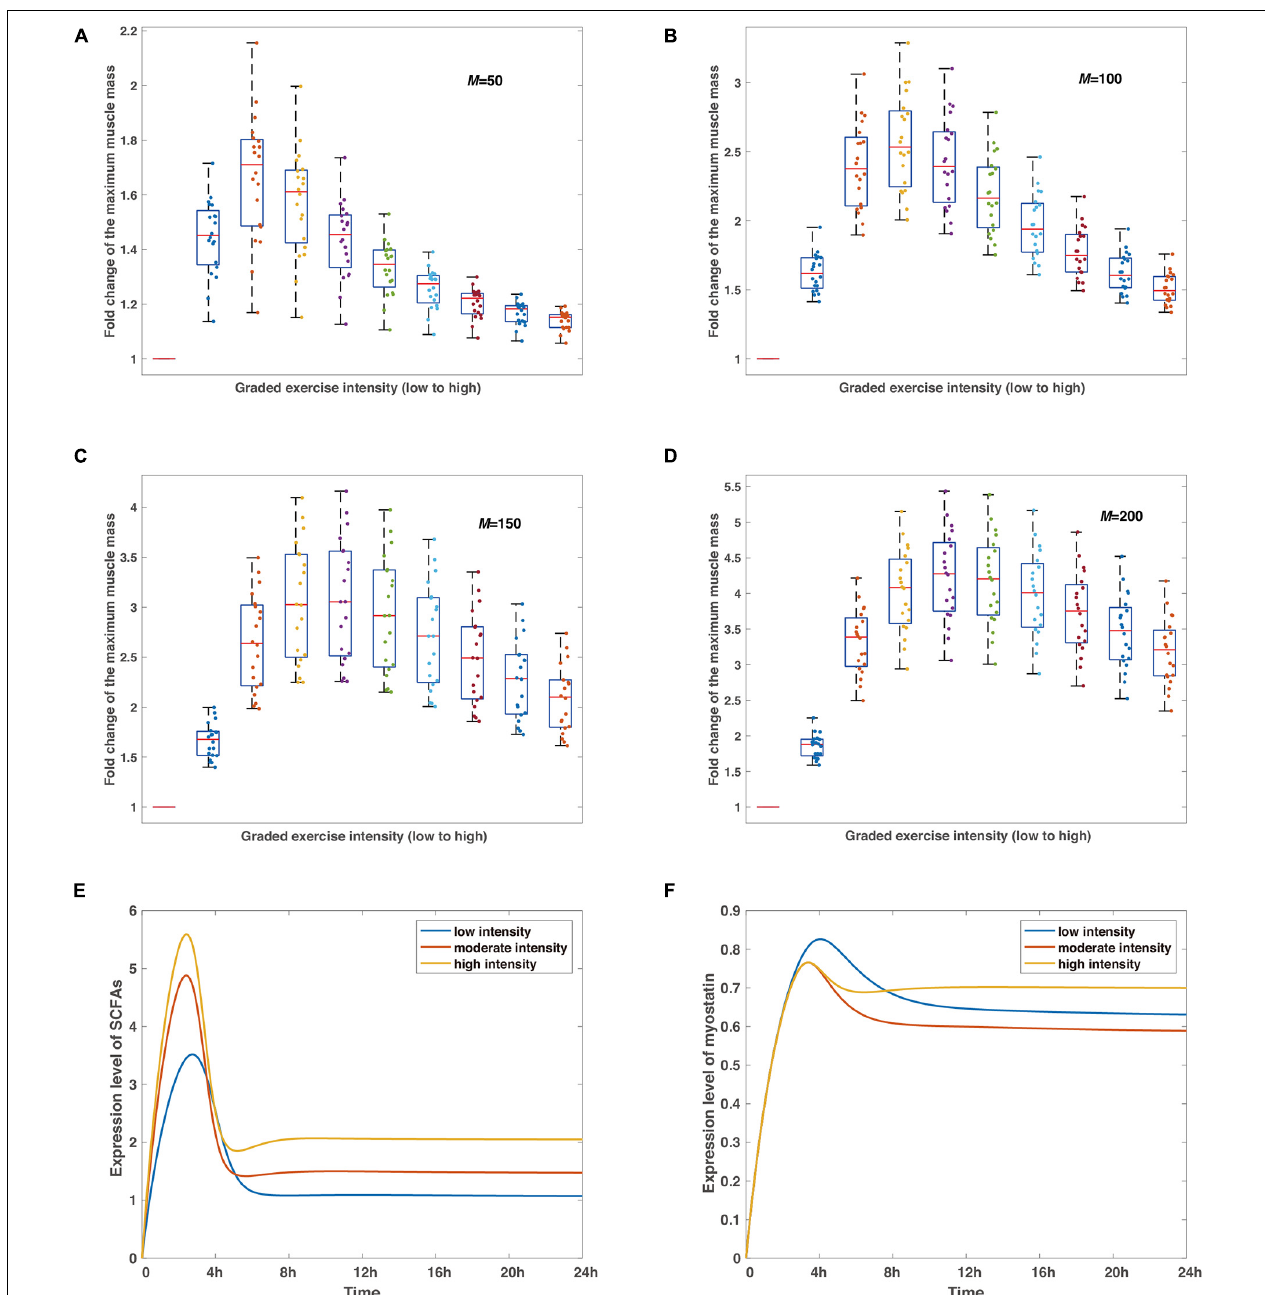
FIGURE 3 | The verifications and predictions of the proposed model. (A–D) The robustness of the non-monotonic relationship between exercise intensity and variation of the maximum muscle mass under perturbations of random noise in representative delay coefficients. Boxplots show the statistics of such relationships at different intensities with red bars in each subfigure reflecting control tests. The delay coefficient M increases from (A) to (D) , simulations are run by 20 times for each condition under the same parameter sets, and the noise perturbation, defined as a Gaussian-distributed random variable N ( 0 , 1 ) with an amplitude of 0 . 001, is applied to each parameter in the model ( Supplementary Table 1 ). Colored dots record the maximum muscle mass at varied exercise intensities for each experiment in silico . (E,F) The predicted dynamics of SCFAs and myostatin. Blue, scarlet, and tan curves stand for low, moderate, and high intensities, respectively. Simulations are run by the timespan of 24